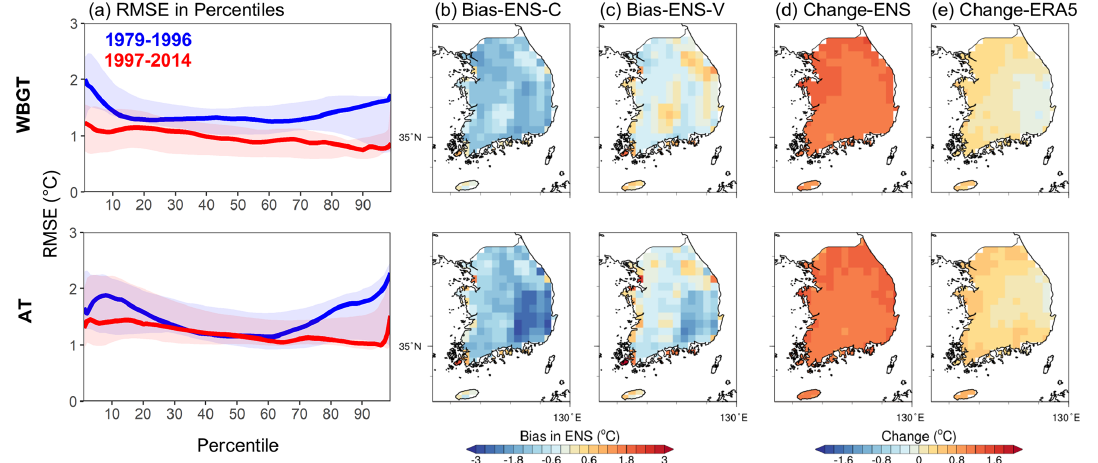
Figure 3. (a) Root mean square error (RMSE; Eq. S1 in the Supplement) over the land area of South Korea in percentiles 1–99 during 1979– 1996 (blue) and 1997–2014 (red). The lines and shading indicate the median and the range, respectively, of the five RCMs. (b, c) Spatial map of the bias in the 90p from ENS during the calibration (C; 1979–1996) and validation (V; 1997–2014) period, respectively. (d, e) The difference between the validation and the calibration period in 90p from ENS and ERA5, respectively. The upper row is for WBGT, and the lower row is for